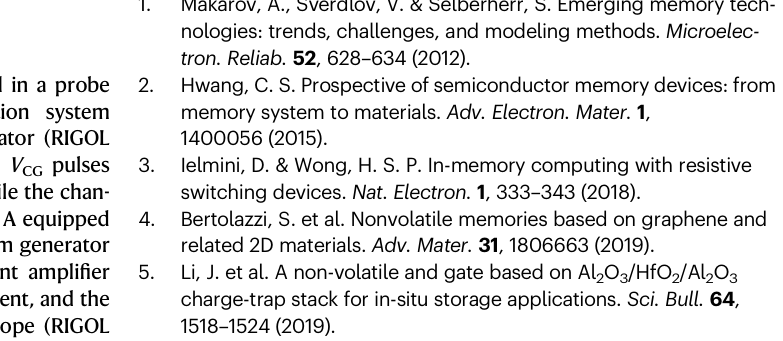
Fig. 5 | Robustness of the low-voltage ultrafast nonvolatile memory and paradigm of multibit storage. Variation of state-0 and state-1 currents as a function of temperature. These currents were read out immediately ( t read =0s) after writing/erasing operations ( a ) and after 10 4 s retention ( t read =10 4 s) ( b ). Var- iation of state-0 and state-1 currents as a function preservation time after device fabrication. These currents were read out immediately ( t read =0s) after